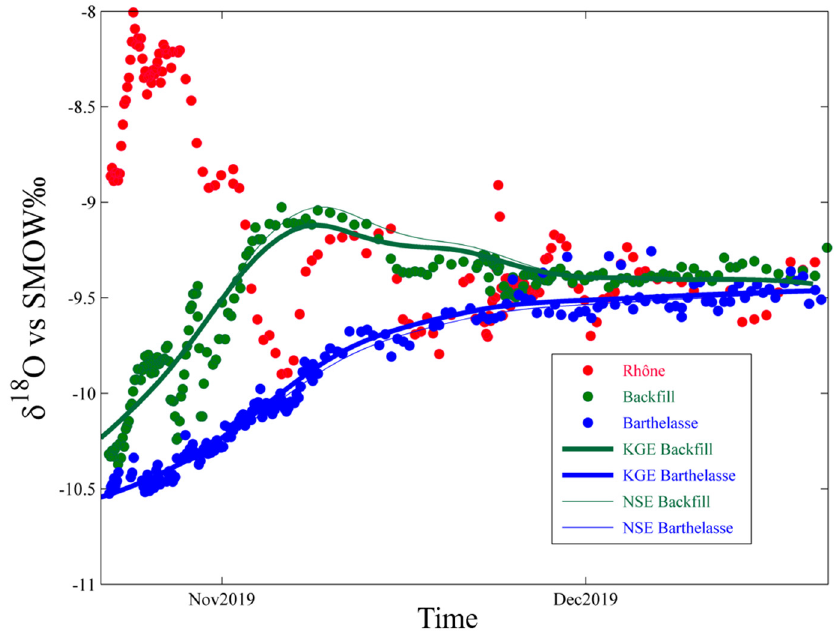
Figure 12. δ 18 O evolution in the Rhône, backfill and Barthelasse during flood monitoring and simulation from dispersive model calibration (points = field samples, curves = models).